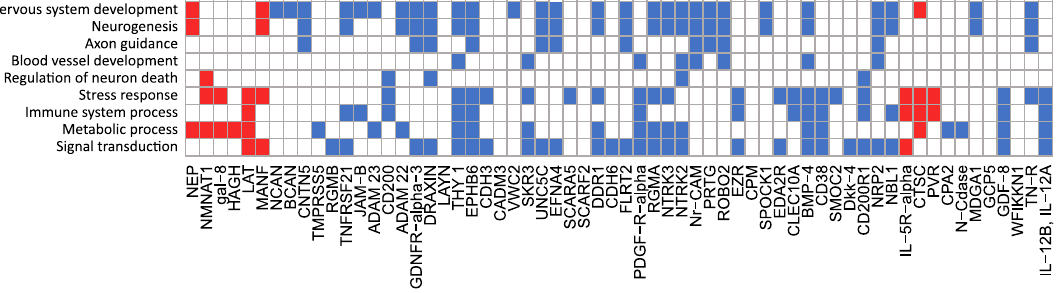
Figure 5. Selected annotated biological functions for 62 candidate acute and/or 3-month protein markers with either statistically significant or suggestive association with acute stroke severity or neurological outcome. Present annotations according to the Gene Ontology (GO) database 18 , version released July 1, 2022, doi: 10. 5281/ zenodo. 67997 22. Proteins are sorted by hierarchical clustering according to Euclidean distance in the acute phase. Annotations are marked in blue for proteins where lower plasma levels in the acute stroke phase were associated with higher NIHSS scores (worse stroke severity or outcome), and red for proteins for which higher plasma levels were associated with higher NIHSS